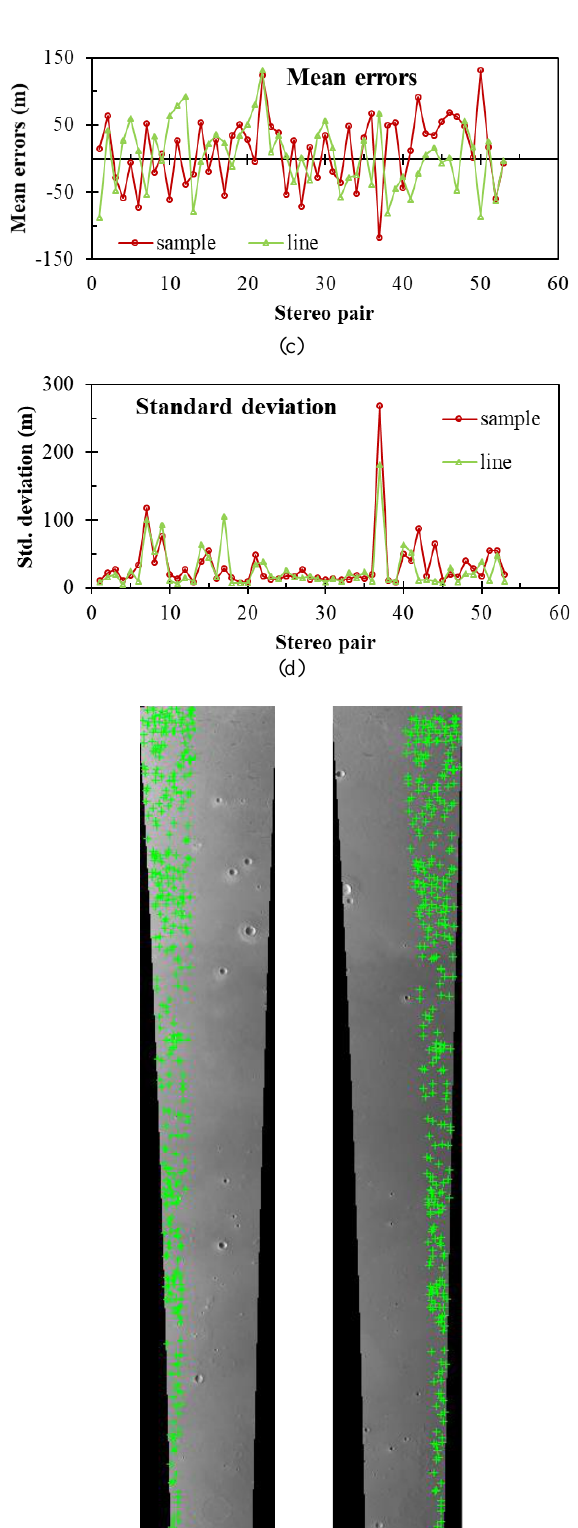
Figure 3. Evaluation results of the initial geopositioning accuracy of the test data. (a) the number of conjugate points per stereopair; (b) maximum errors between stereo images; (c) mean errors between stereo images; (d) standard deviation between stereo images; (e) conjugate points drawn on h5097 nd2 orthophoto; and (f) conjugate points drawn on h5115 nd2